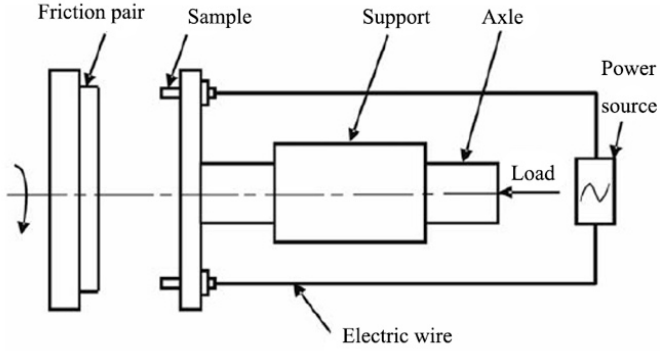
Figure 1. Schematic diagram of high-speed, current-carrying test platform.